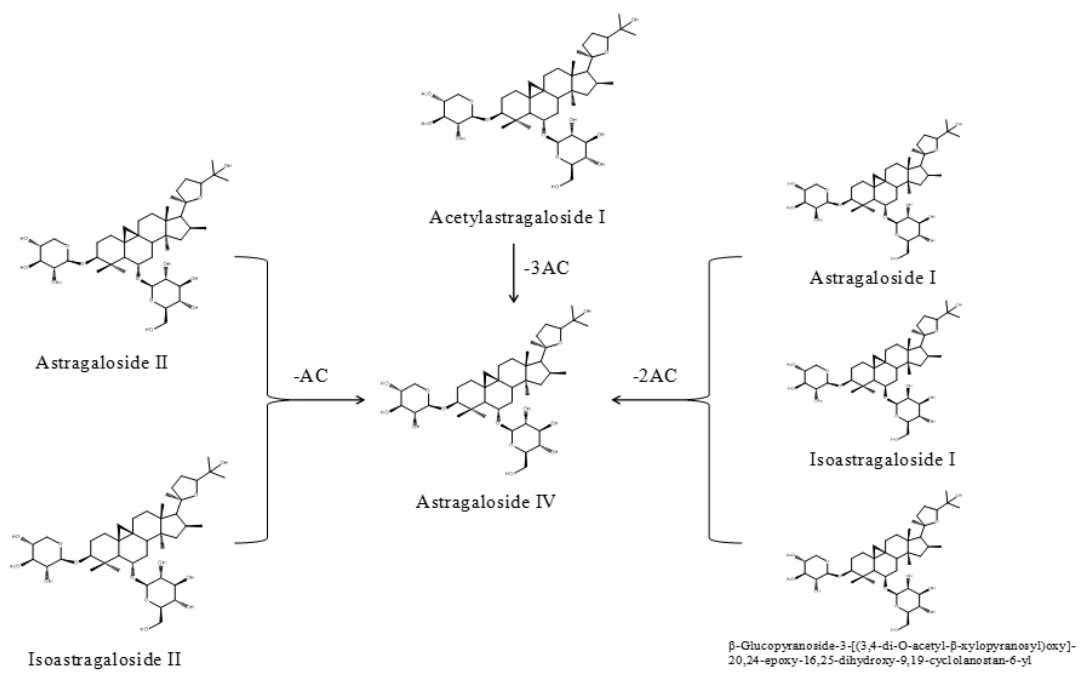
Figure 7. The probable transformations of astragaloside IV.